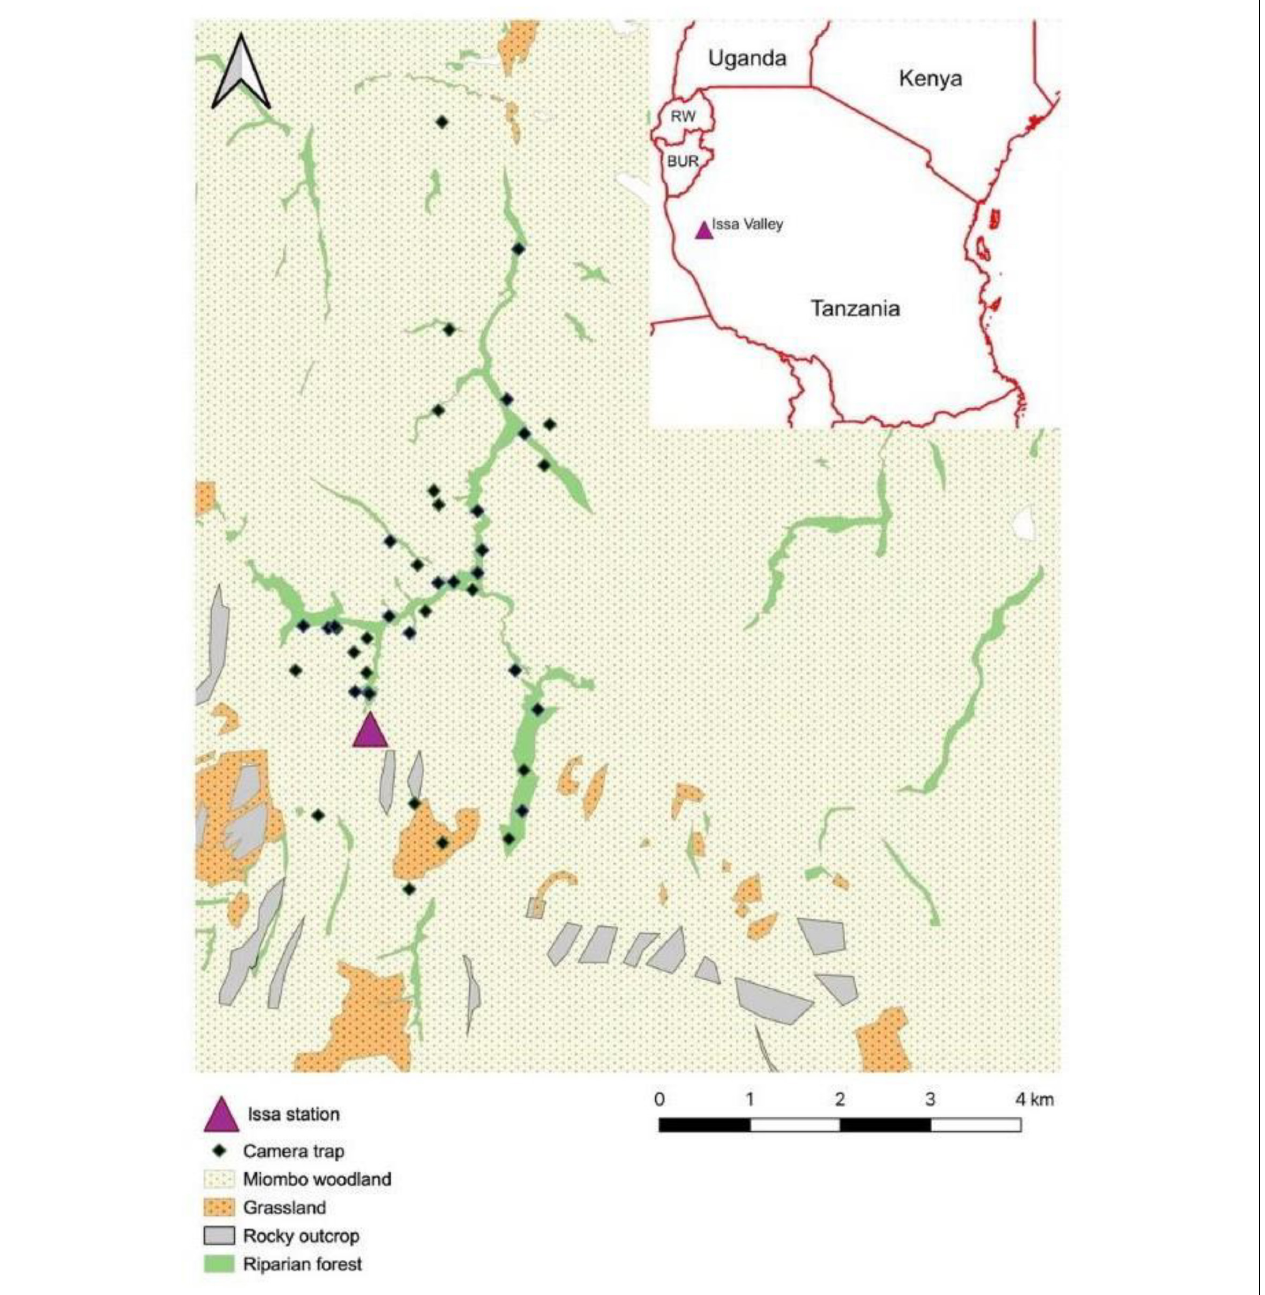
FIGURE 1 | Location of the camera traps ( n = 42) deployed between January 2016 and December 2018 in the Issa Valley, in relation to the different vegetation types. The Issa station represented the main research base for the study. The camera trap site in “grassland/swamp” was instead located in a patch of deciduous woodland, and thus corrected upon field examination of the